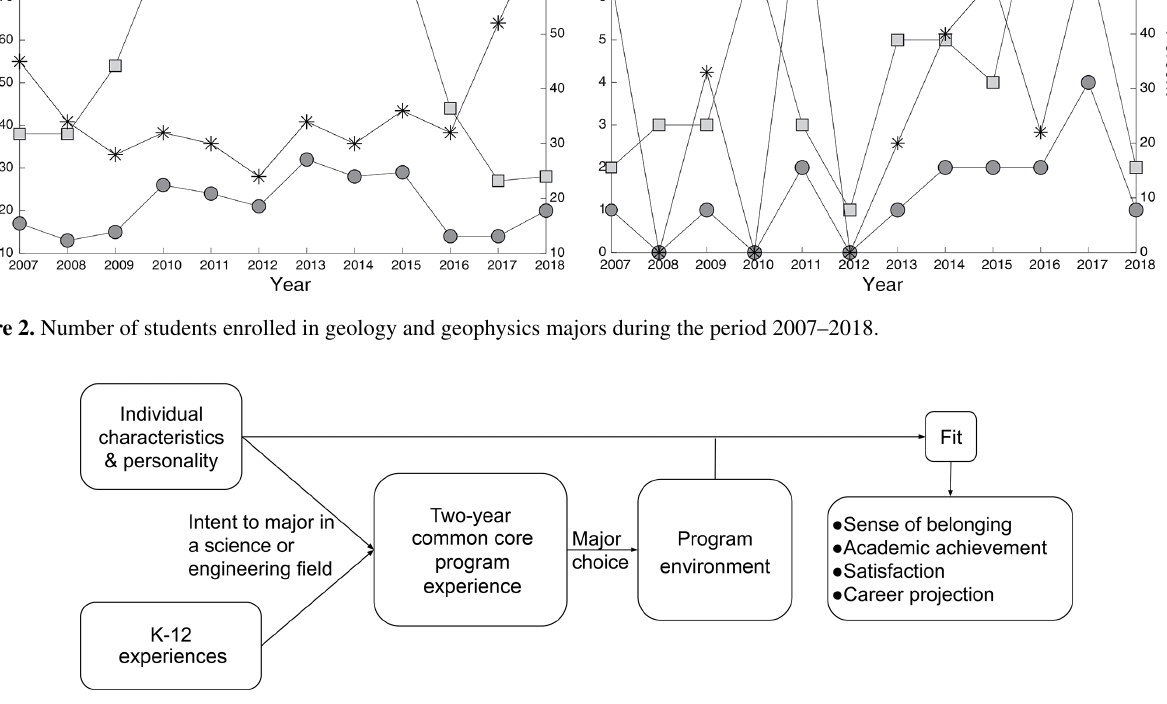
Figure 3. Personality–environment fit framework adapted for the FCFM